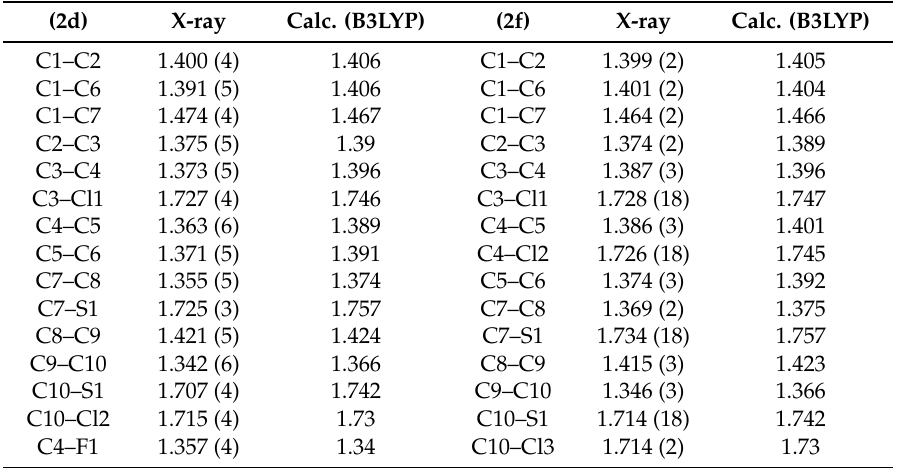
Table 2. Some selected X-ray and simulated bond lengths (Å) of 2d and 2f (atomic labels are with reference to ORTEP plot Figure 3).